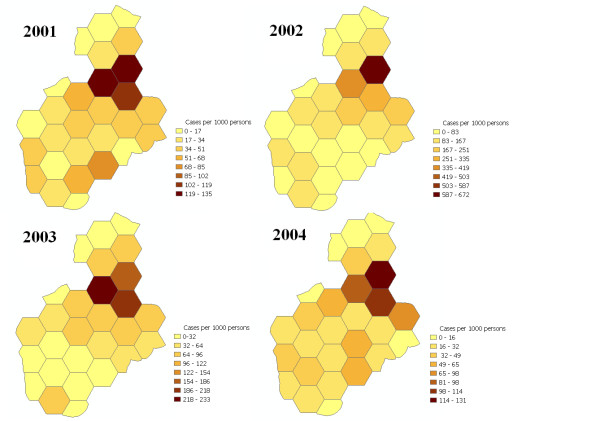
Area-wide variations in malaria incidence (cases/1000 persons/year), 2001–2004. Note: scale is different for each year.